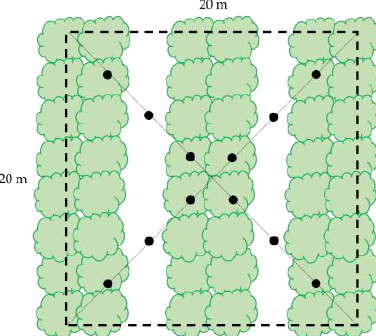
Figure 4. Sampling approach adapted for the tomato row plant spacing. Table 3. CC (%) field measurements.